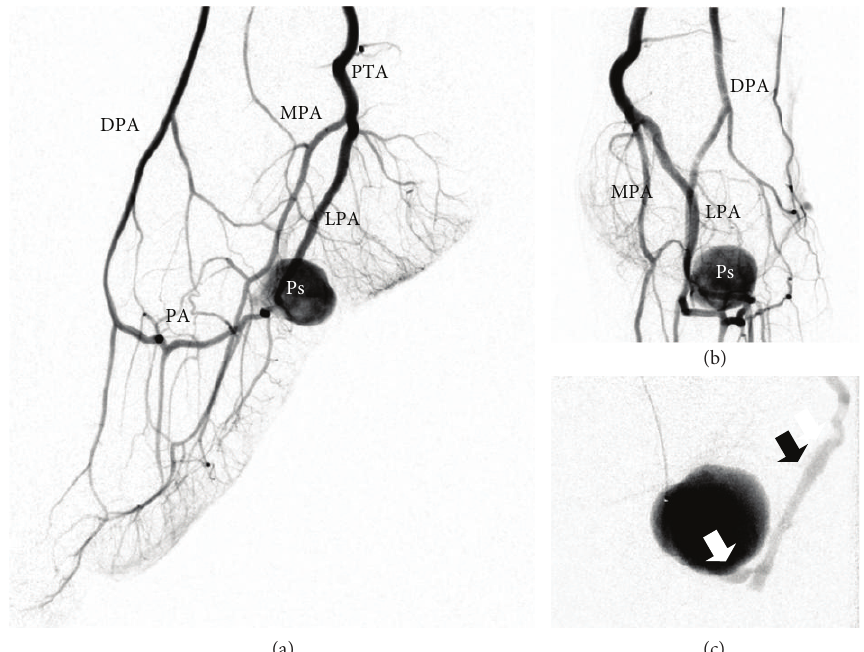
Figure 2: Diagnostic angiography through the 4-Fr catheter in the popliteal artery ((a), (b)), respectively, the microcatheter in the plantar arch (c). White arrow = arteriovenous fistula. Black arrow = early filling of a dilated vein. DPA = dorsalis pedis artery. PA = plantar arch. MPA = medial plantar artery. LPA = lateral plantar artery. PTA = posterior tibial artery. Ps =